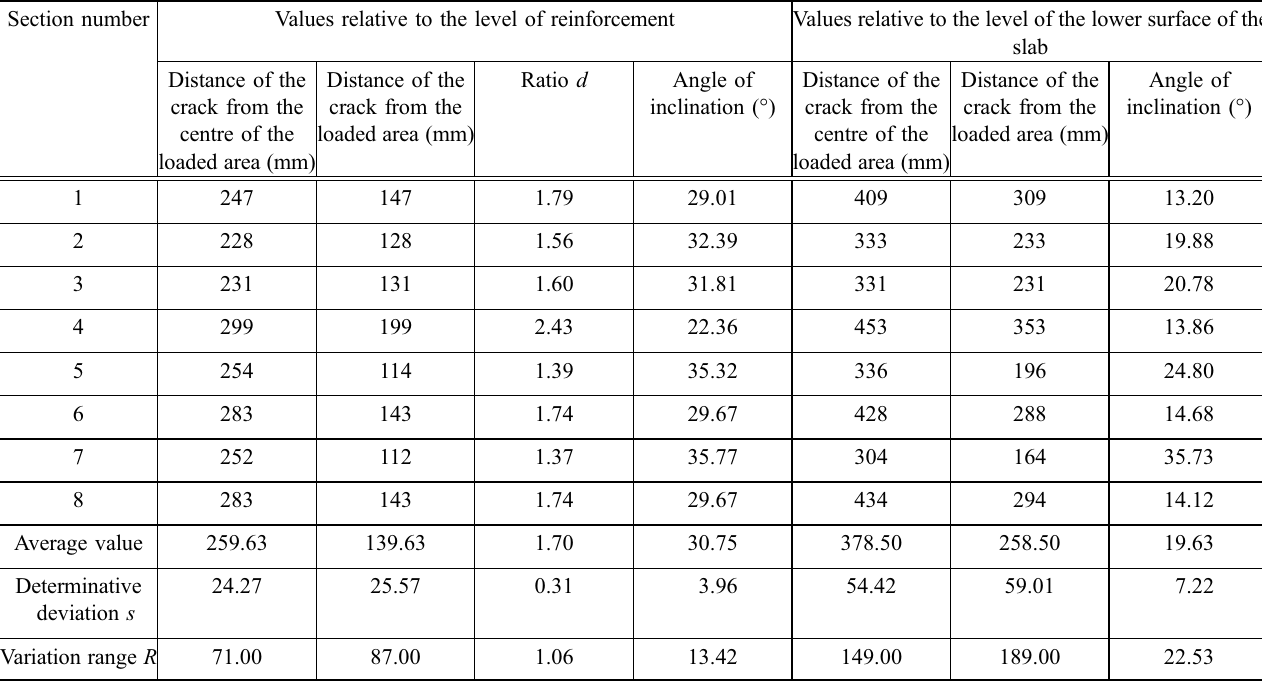
Fig. 9 Comparison of the measured values and the results of the design methods used in EC2 in diagonal cuts of the slab (mm). Table 1 Evaluation of real location of the